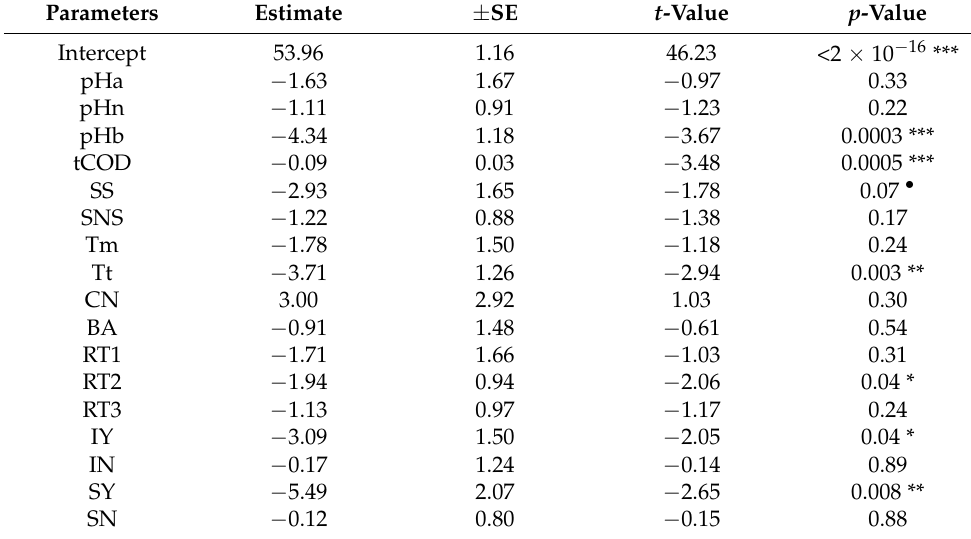
Table 7. Correlation between hydrogen content and operation parameters. Symbols